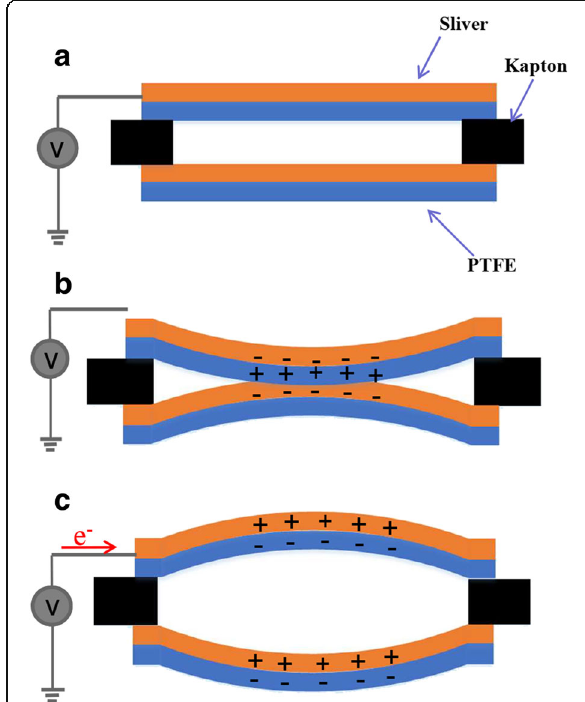
Fig. 6 The diagram of the working principle of the sensor. a Rest state, in which the PTFE is not charged, without sound stimulation. b Contact state, in which the upper PTFE membrane is negatively charged, under sound pressure. c Separate state, in which the upper and lower PTFE membrane separate from each other, the potential difference drives free electrons to flow from the ground to silver electrode through the external